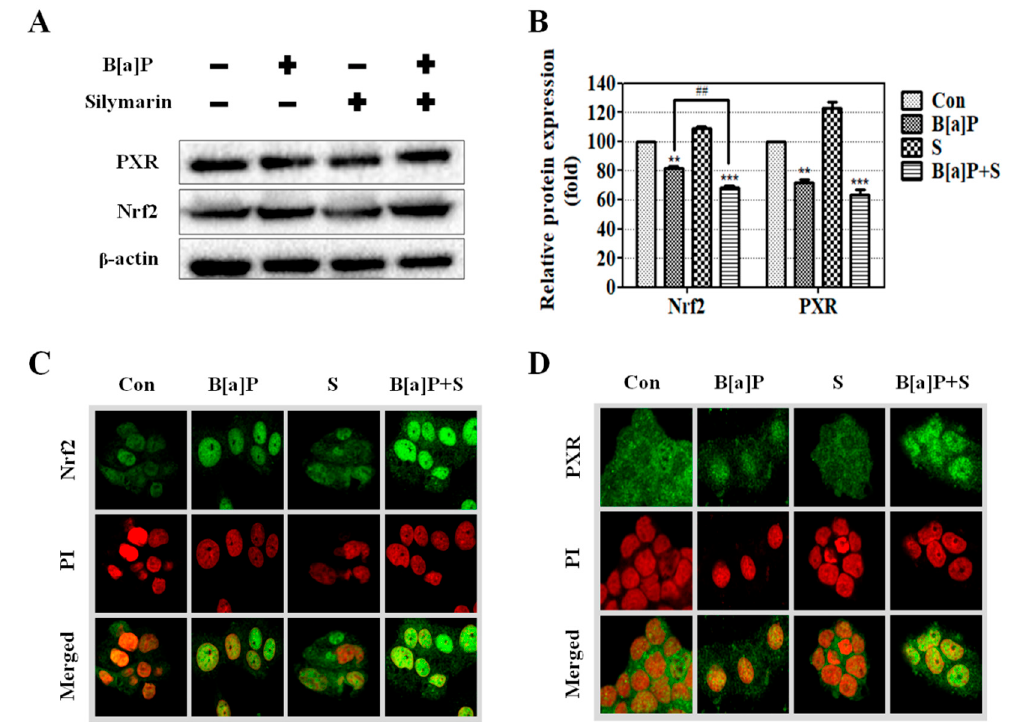
Figure 4. HepG2 cells were treated with B[a]P (10 µ M), silymarin (40 µ M), and both B[a]P (10 µ M) and silymarin (40 µ M). ( A ) Nuclear factor erythroid 2-related factor 2 (Nrf2) and pregnane X receptor (PXR) expression was measured using Western blot, and ( B ) the quantitative protein levels were calculated. ( C , D ) The translocation levels were measured by immunocytochemistry. DNA was detected by propidium iodide (PI) staining (red).